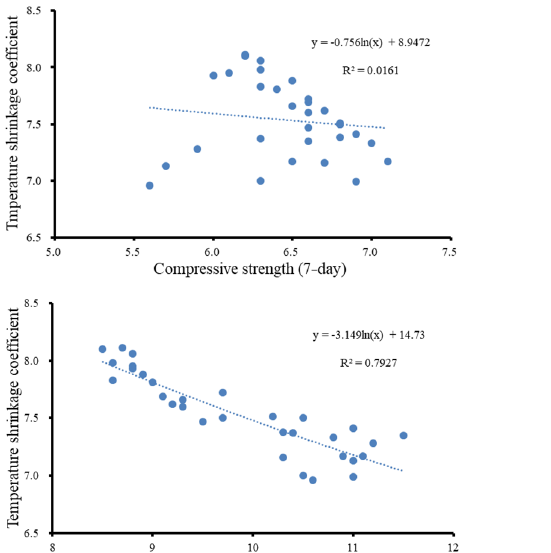
Figure 9. Relationships between spliing strengths and dry shrinkage coefficients.